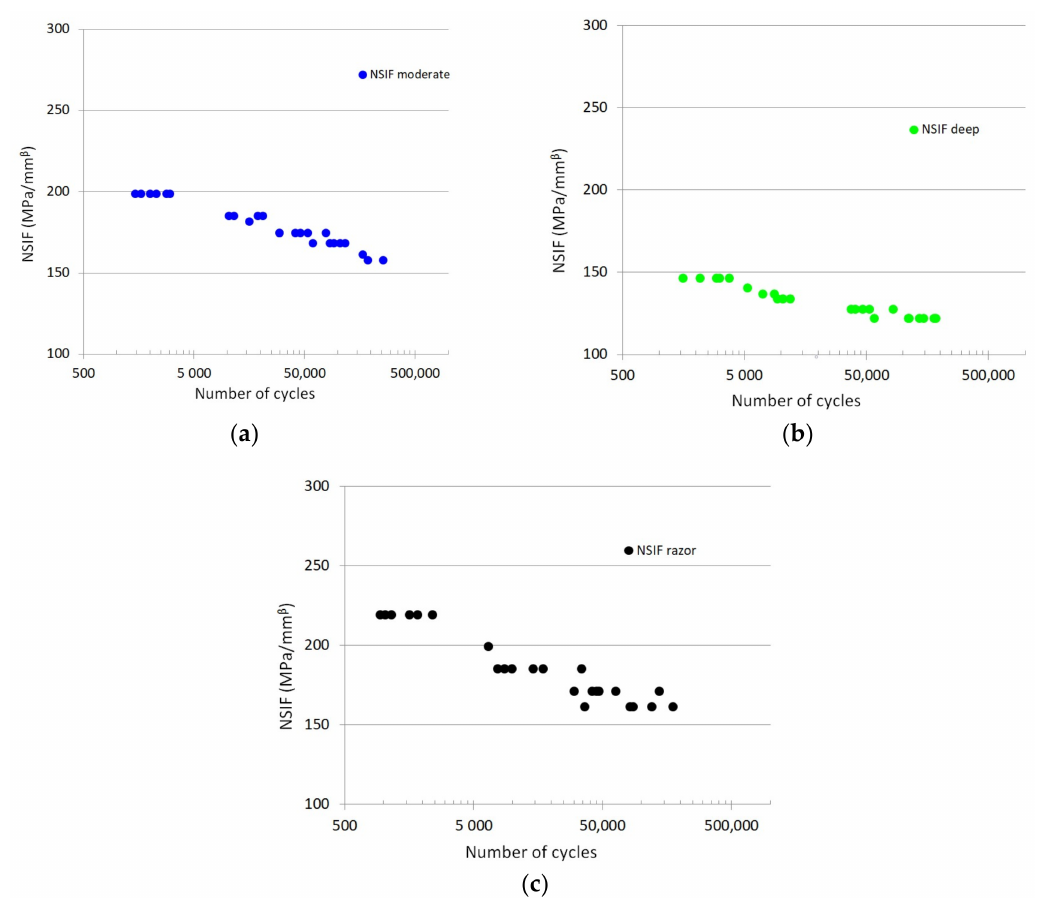
Figure 4. Fatigue NSIF-N curves for specimens labelled as moderate ( a ), deep ( b ) and razor ( c ), where β is equal to